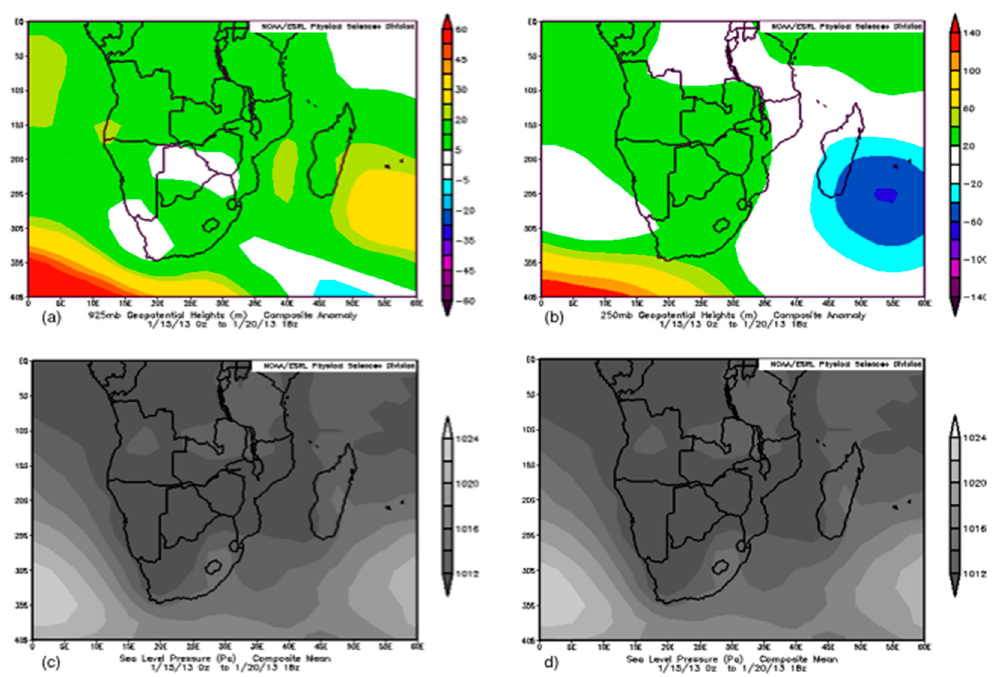
Figure 4. Geopotential height anomalies (m) and mean sea level pressure (Pa) at 925 mb ( a , c ) and at 250 mb ( b , d ). (https://www.esrl.noaa.gov/psd/data/composites/hour/).